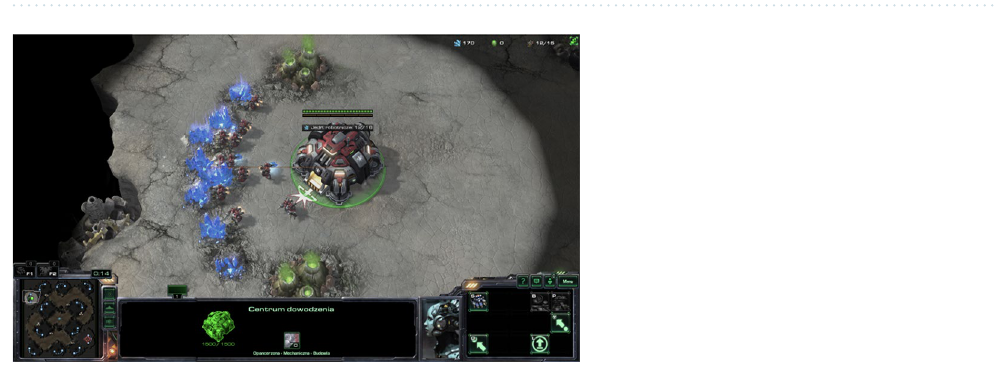
Figure 1. Graphic presentation of the study design. Data from a marked time range were used in this study. MRI magnetic resonance imaging, EEG electroencephalography.